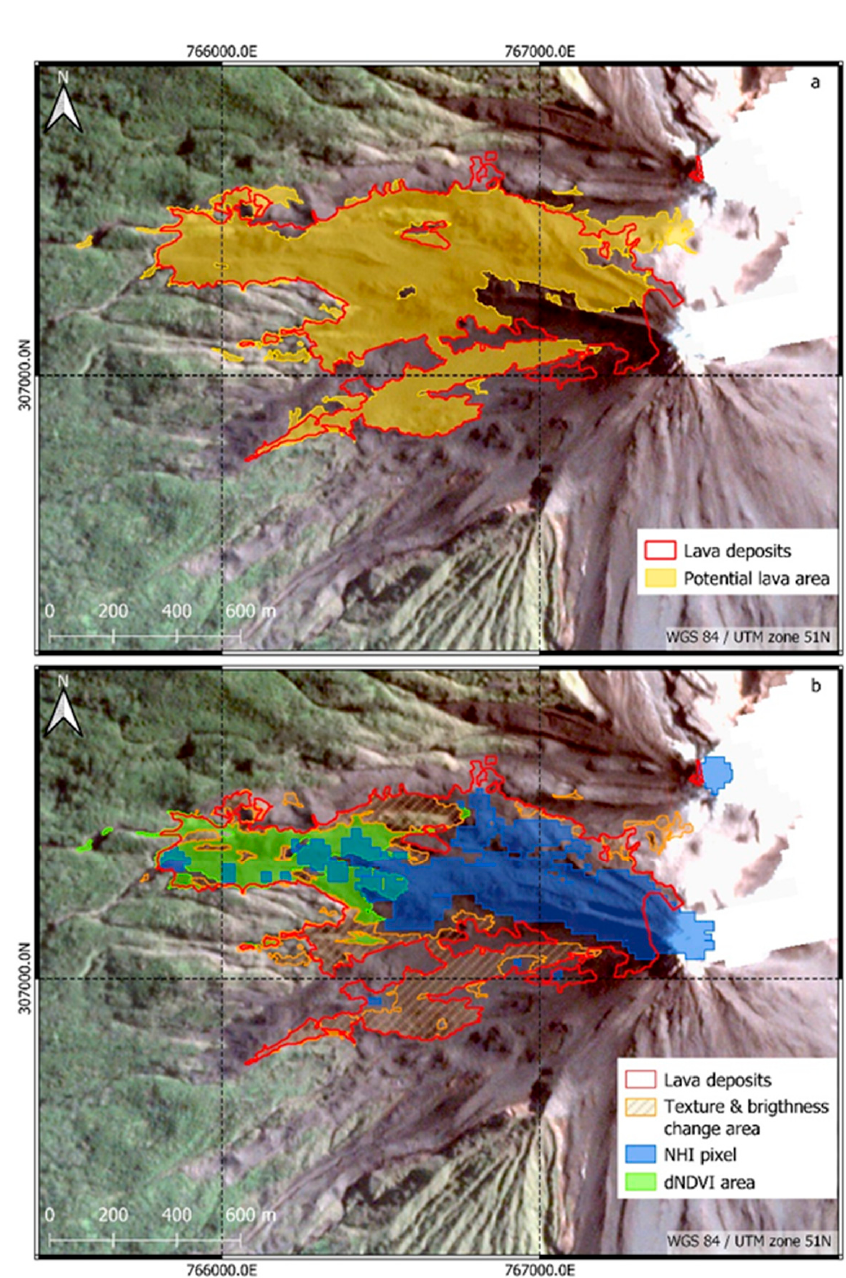
Figure A1. ( a ) Potential lava areas based on distance to discharge model (TanDEM-X). All areas in the “potential lava area” class are within 45 m of the nearest point to the extracted drainage flow. ( b ) Areas based on thermal overprinting (NHI area) and vegetation changes ( dNDVI area). These areas are considered to be volcanically overprinted and thus are certainly covered with lava deposits. They form the basis for modelling lava flows in the areas with texture and brightness changes. Areas in the “change area” class were classified based on GLCM and brightness thresholds and are within the “potential lava area” class. Based on the NHI and dNDVI area, region-growing modelling is performed into the “change area”.